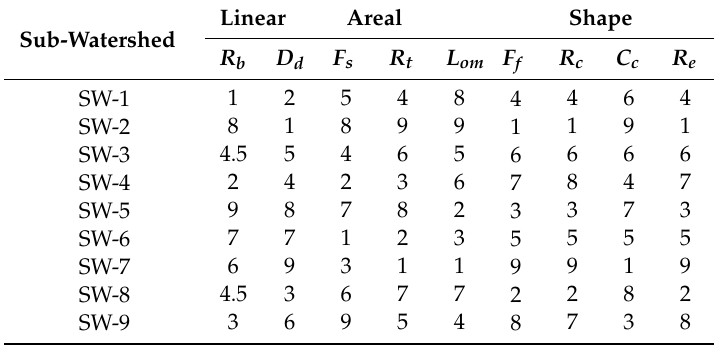
Table 6. PPR of nine sub-watersheds based on linear, areal, and shape variables. Linear Areal Shape Sub-Watershed R b D d F